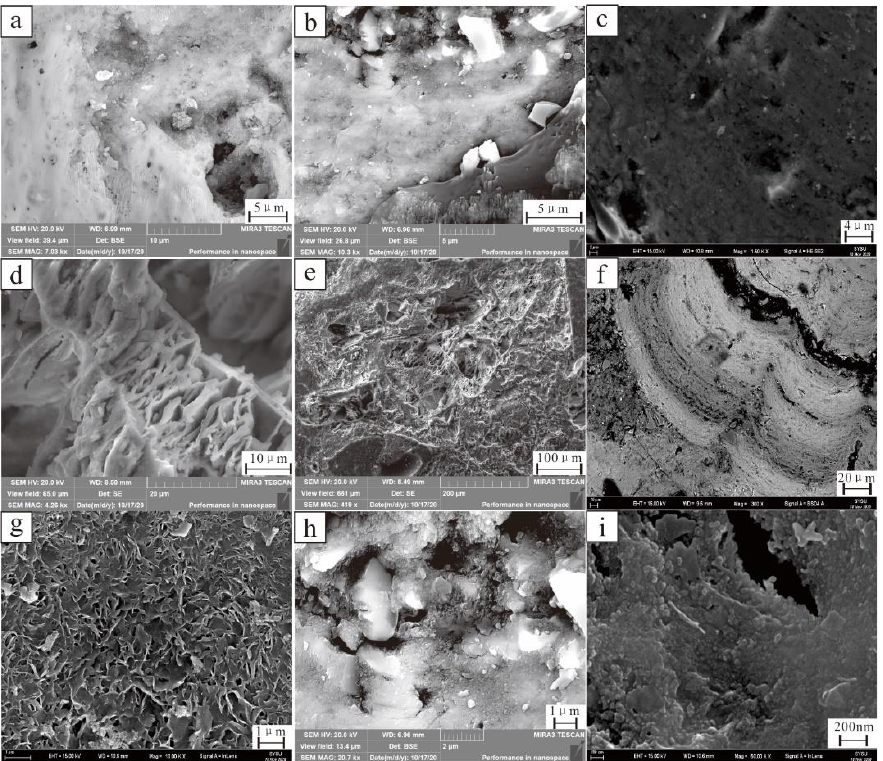
Figure 5. SEM images of the core of polymetallic nodules. ( a ) polymetallic nodule core; ( b ) quartz grains; ( c ) feldspar; ( d ) altered feldspar; ( e ) clay minerals; ( f ) iron-manganese phase minerals; ( g ) clay minerals in a dense shell; ( h ) growing quartz grains in a shell; ( i ) nanomineral particles.